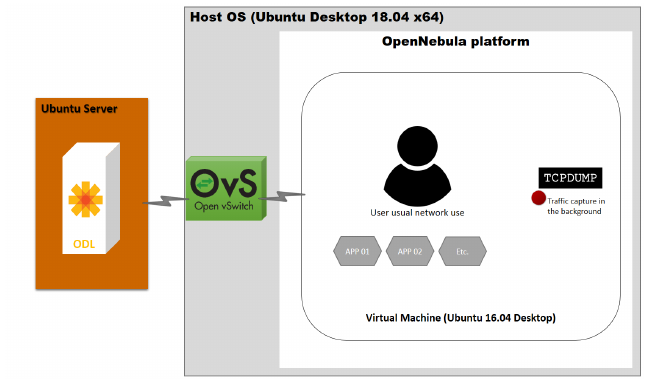
Figure 2. Data collection process.